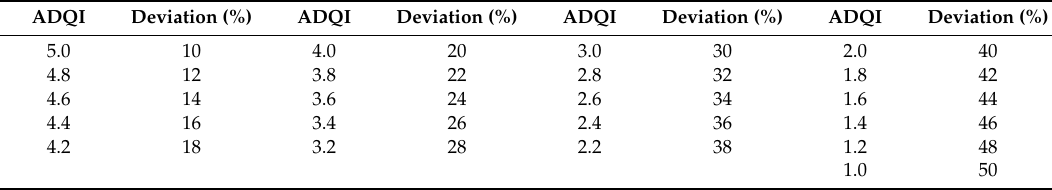
Table 2. Aggregated data quality indicator (ADQI) values and deviation levels [54,60].